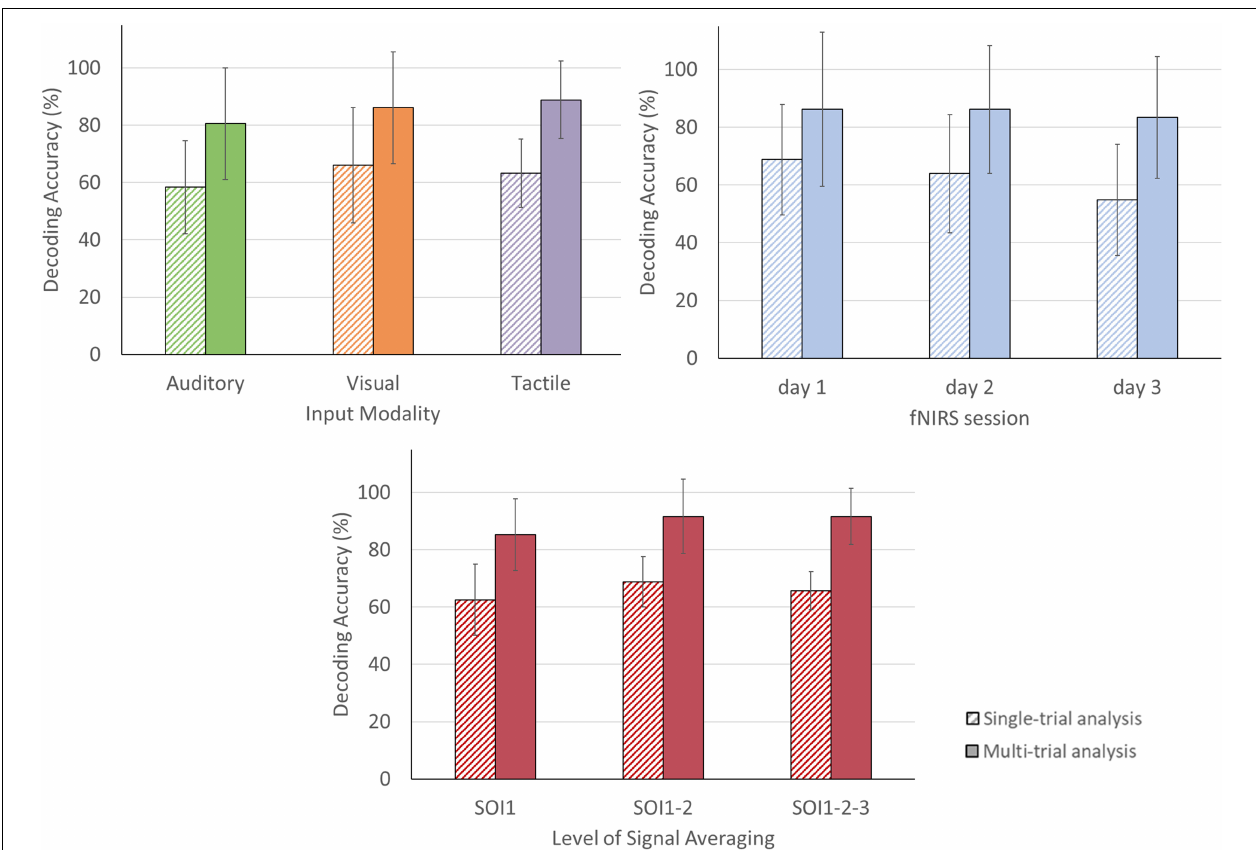
FIGURE 6 | Single- and multi-trial group mean answer decoding accuracy per sensory encoding modality, fNIRS session and level of signal averaging. Accuracies are depicted for the single-trial (striped bars) and multi-trial (solid bars) analysis. Top left : Accuracies according to sensory encoding modality. Note that all sensory encoding modalities were effective. Top right : Accuracies according to fNIRS session. Note that the multi-trial accuracies remained relatively stable over the three fNIRS sessions. Bottom : Accuracies according to level of signal averaging. Note that averaging across two (SOI1-2) or three (SOI1-2-3) signals slightly outperforms the single channel-by-chromophore approach (SOI1). The error bars depict the standard deviation of the group mean. Abbreviations: SOI, signal-of-interest.